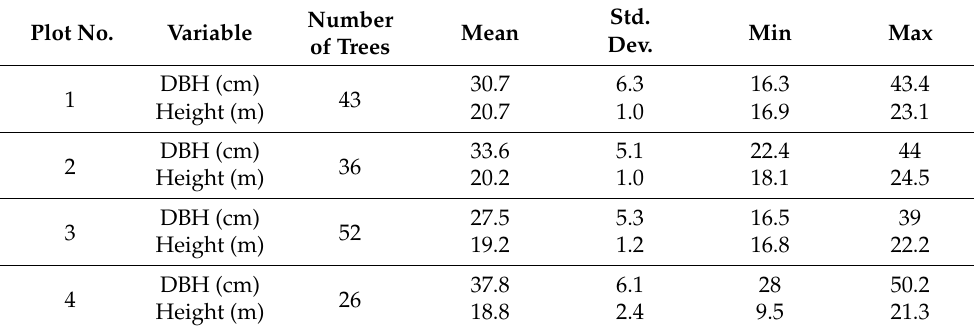
Table 2. Summary of statistics for sample trees in each sample plot.